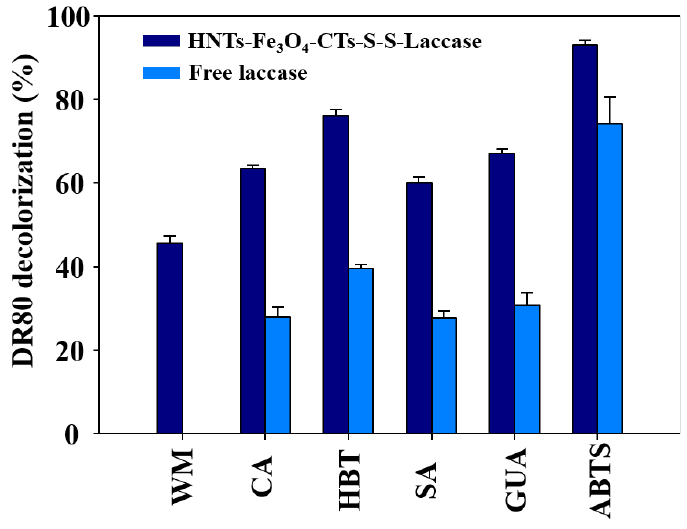
Figure 8. Removal of the DR80 by free laccase and HNTs-Fe 3 O 4 -CTs-S-S-Laccase; without a mediator (WM), and with redox mediators of CA, HBT, SA, GUA, and ABTS.